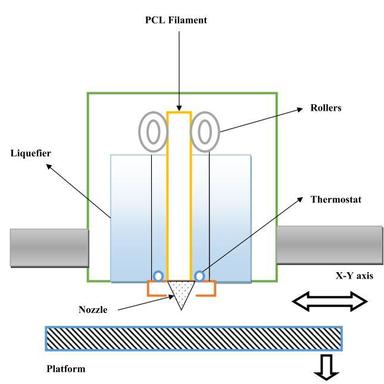
Basic of description of fused deposition modelling.